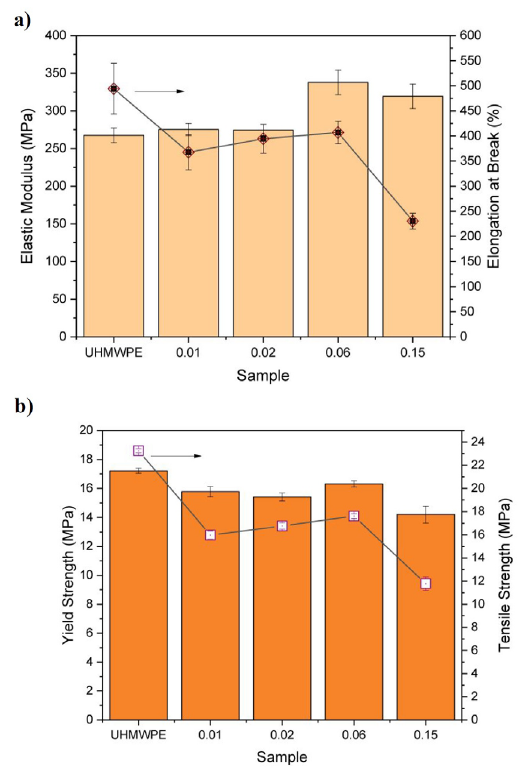
Figure 5. TGA curves for the samples: a) Mass Loss and b) Mass Loss Rate.